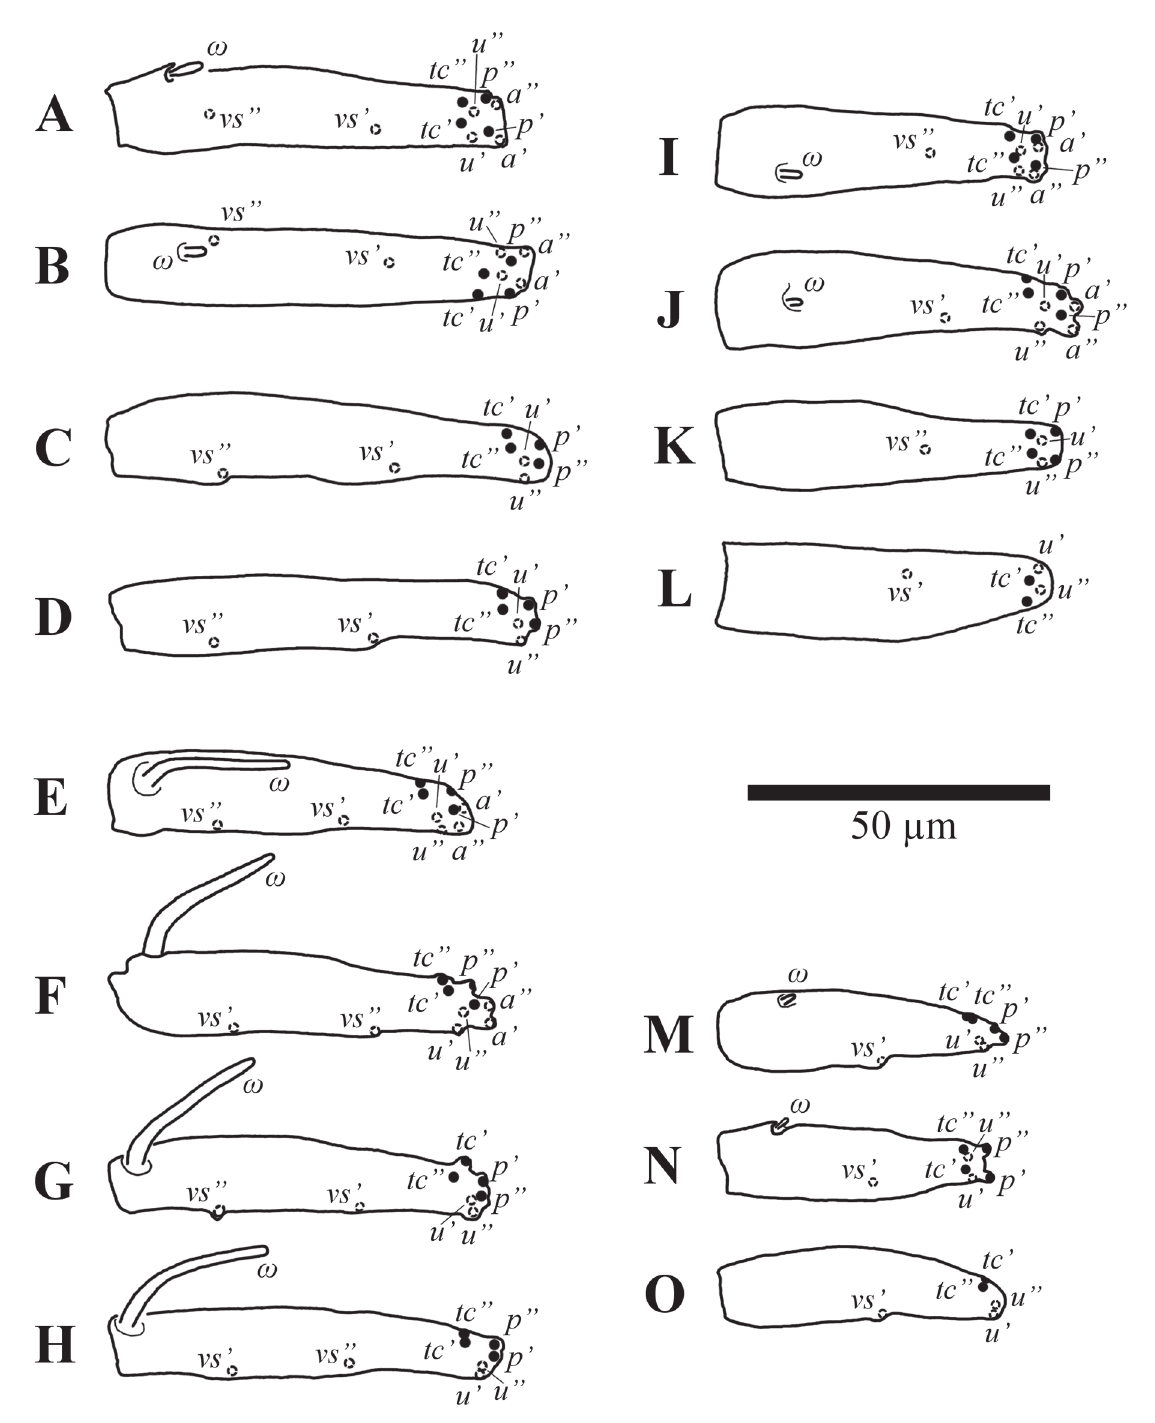
Fig. 4. Schematic tarsal setations of Neophyllobius cibyci sp. nov. A–D . ♀, holotype. A . Tarsus